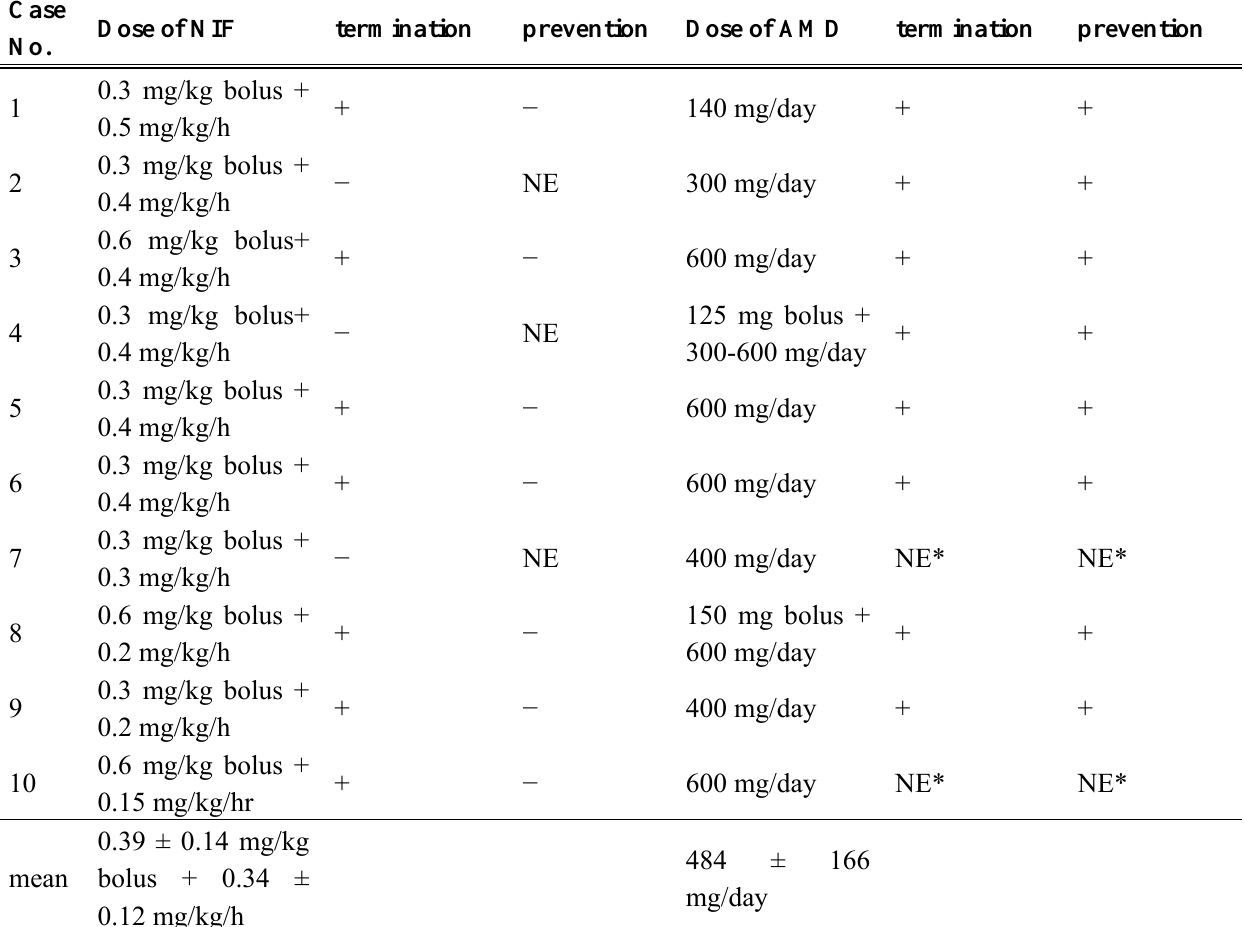
Table 2. Effects of class-III drugs on ventricular